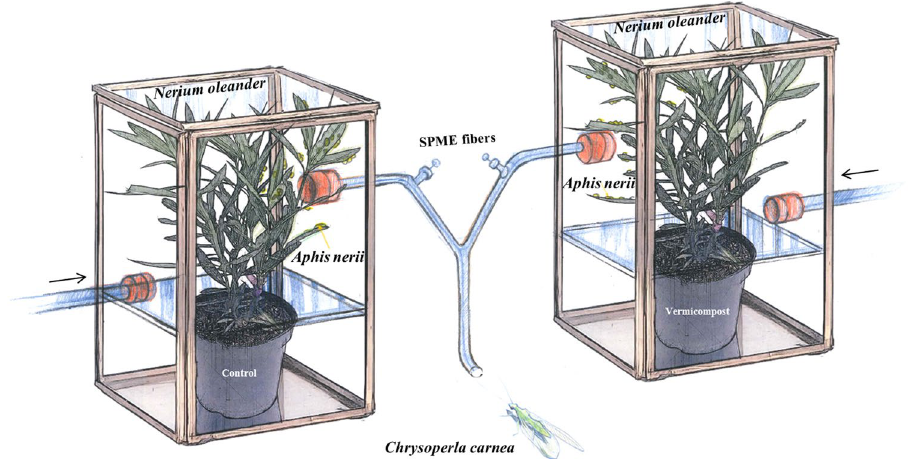
Figure 1. Regulated olfactometer system comprising Nerium oleander plants grown in a potting soil initially containing a sterile (Control)/non sterile (Vermicompost) inoculum, the herbivorous Aphis nerii and the generalist predator Chrysoperla carnea